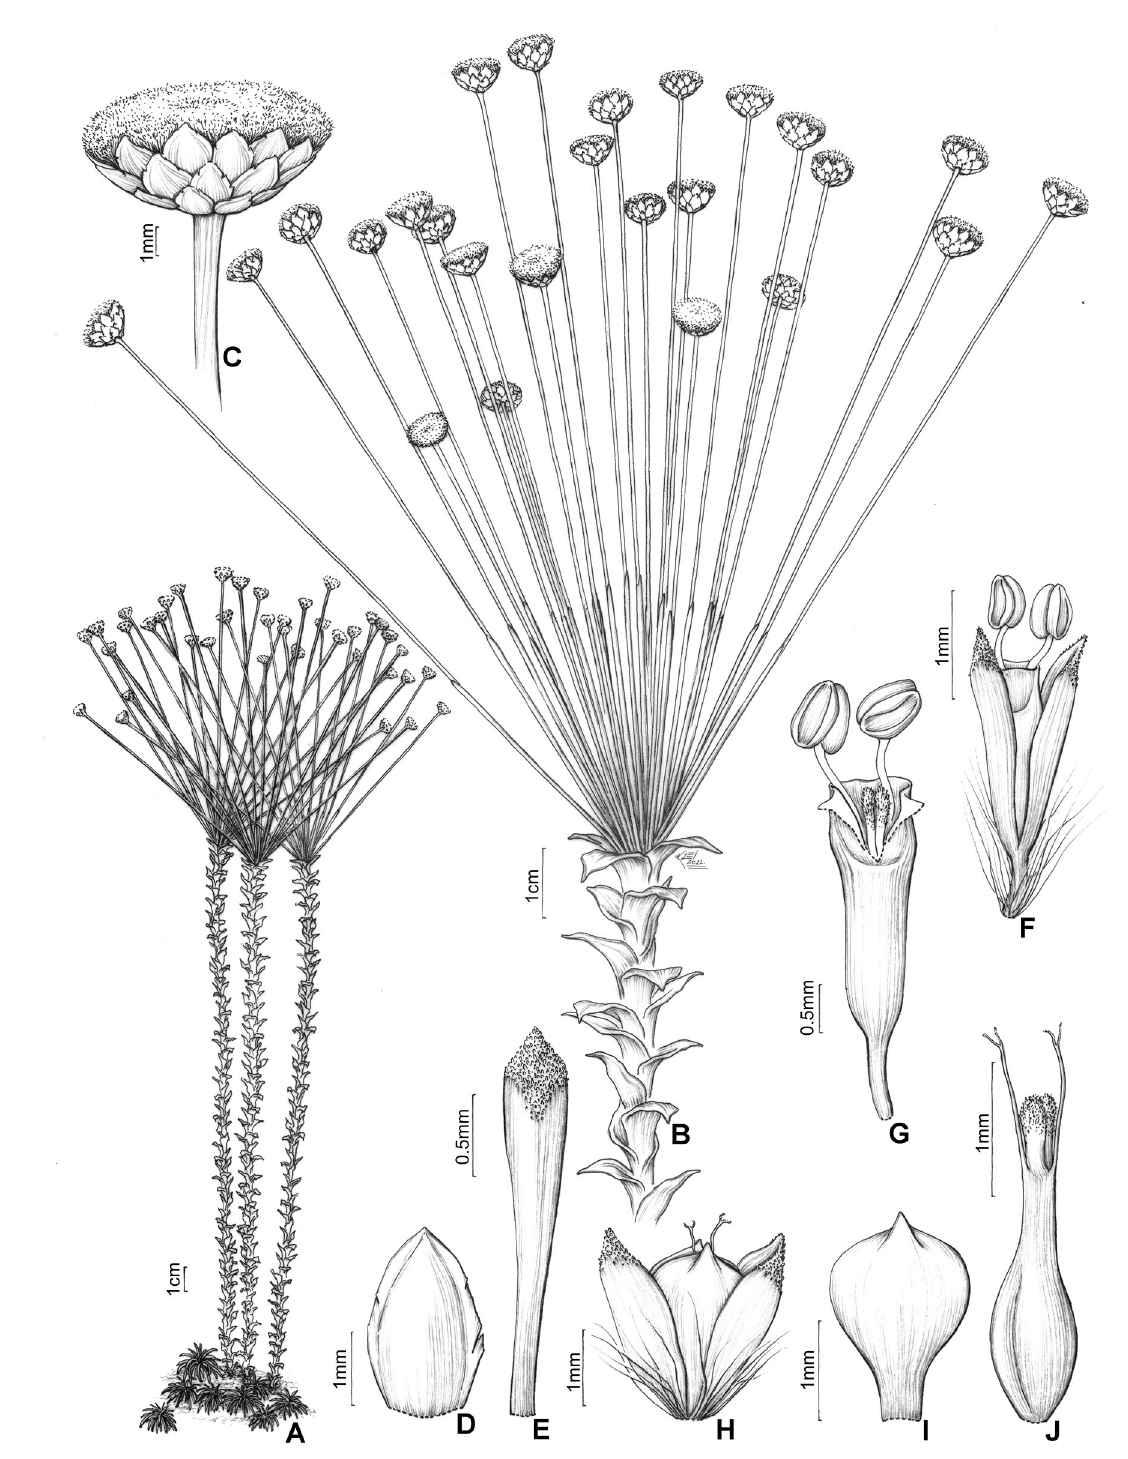
Fig. 4. Paepalanthus irwinii Trovó & Echtern. sp. nov. A . Habit. B . Inflorescence and reproductive apex detail. C . Capitulum detail. D . Involucral bract, abaxial surface. E . Floral bract, abaxial surface. F . Staminate flower. G . Staminate flower with sepals removed and corolla opened. H . Pistillate flower. I . Petal of the pistillate flower, abaxial surface. J . Gynoecium. ( M.L.O. Trovó et al. 706 –